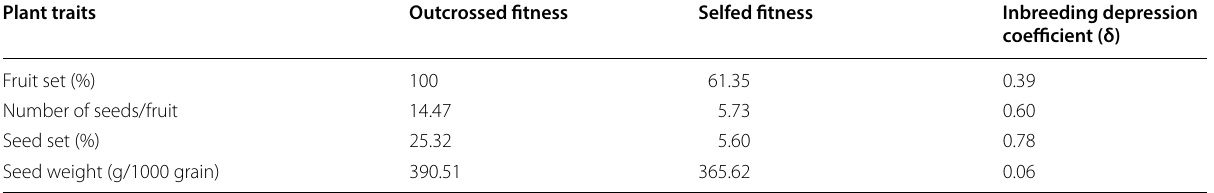
Table 4 Fitness of selfed and outcrossed progeny, and inbreeding depression coefficient (δ) of different traits Plant